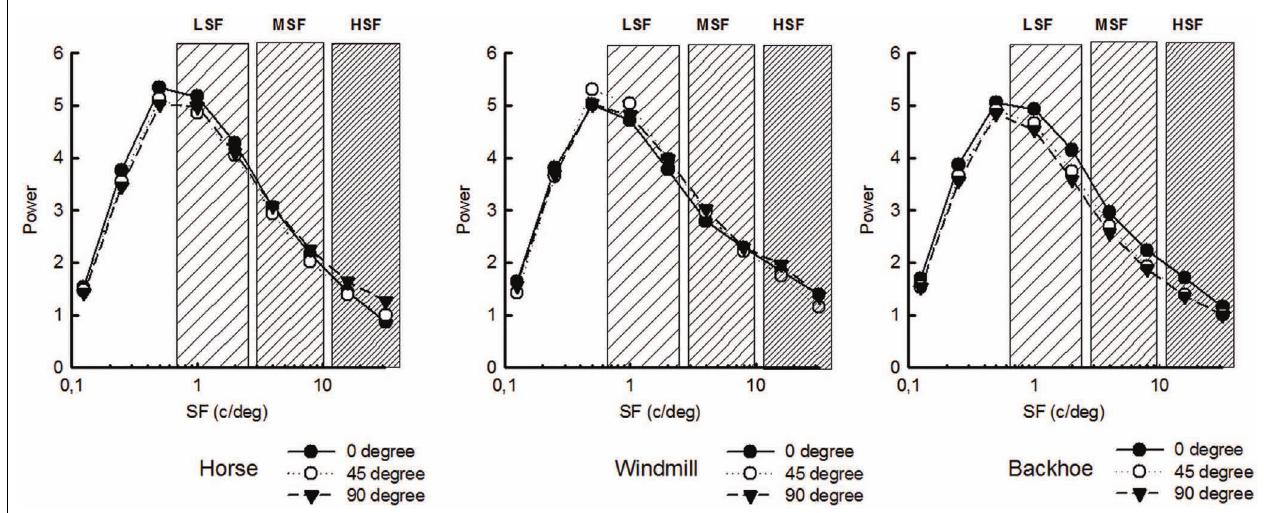
FIGURE 2 |Amplitude as a function of SF for each image of object at all viewpoints. Note the high similarity between stimuli.The dashed boxes represent the filters (LSF, MSF, and HSF).